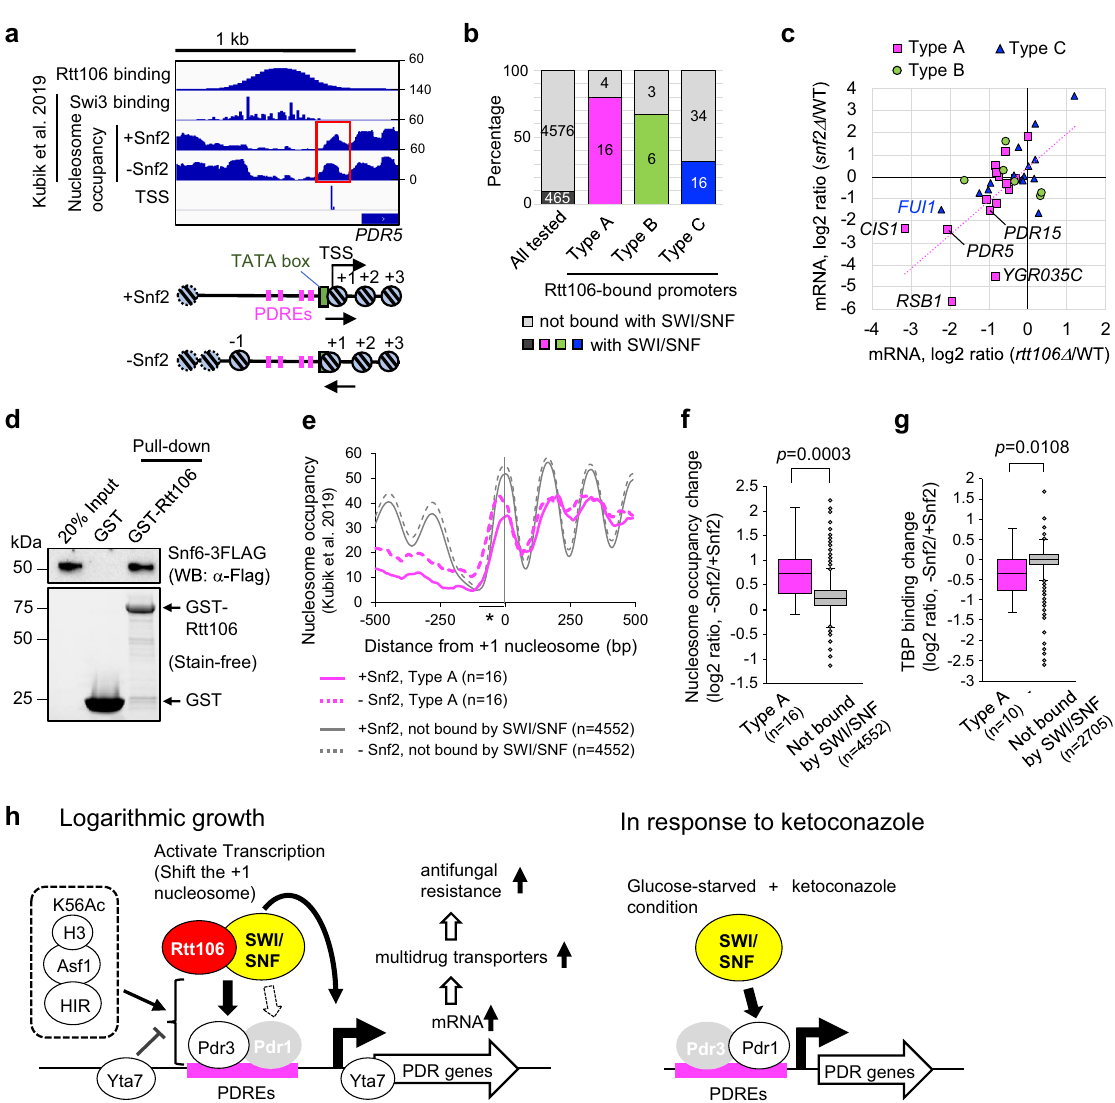
Fig. 6 SWI/SNF colocalises with Rtt106 and regulates TSS-associated nucleosome position at PDR network gene promoters. a Nucleosome positioning at the PDR5 promoter in the presence and absence of Snf2. Binding of the Swi3 SWI/SNF subunit (ChEC-seq) and nucleosome occupancy (MNase-seq) at the PDR5 promoter were extracted from published datasets 20 . TSS TSS-seq extracted from Malabat et al. 2015 49 . Snf2 depletion resulted in shift of the + 1 nucleosome at the PDR5 promoter (red rectangle). b Percentages of gene promoters strongly bound by SWI/SNF and those by Rtt106. The list of gene promoters strongly bound with SWI/SNF was obtained from Kubik et al. 2019 20 . Promoters bound by Rtt106 were de fi ned as in Fig. 2. c Changes in mRNA levels of genes with promoters bound by both SWI/SNF and Rtt106 (as in b ), and correlation of snf2 Δ and rtt106 Δ effects in YPD. Magenta dashed line shows trend for Type A. Data represents means of three biological replicates. d GST pull-down analysis showing GST-Rtt106 interacts with SWI/SNF puri fi ed from yeast cells. e Nucleosome occupancies at Type A promoters bound by SWI/SNF (magenta lines) and promoters not bound by SWI/SNF (grey lines), and those in the absence of Snf2 (dashed lines). Datasets in Kubik et al. 2019 20 were utilised. Asterisk, region analysed in f and g . f , g Nucleosome occupancy change ( f ) and TBP binding change ( g ) caused by loss of Snf2 at Type A promoters bound by SWI/SNF. Normalised reads in regions spanning − 100 to 0 bp from the dyad of the + 1 nucleosome (indicated by asterisk in e ) were extracted from published datasets 20 . For analysis of TBP binding change, promoters with low TBP binding (<50 normalised reads) were eliminated. Boxplots indicate median (middle line), interquartile range (box), outliers denoted by points greater than ±1.5 × interquartile range (single points) and the rest of the data distribution (whiskers). Mann – Whitney tests (two-sided). h Proposed roles of Rtt106 and SWI/SNF in transcription of the PDR network genes in S. cerevisiae (S288C). Rtt106 and SWI/SNF are recruited to the PDR network gene promoters dependent on Pdr3, to mediate Pdr3-dependent transcription during logarithmic growth phase, while SWI/ SNF upregulates their Pdr1-dependent expression in response to